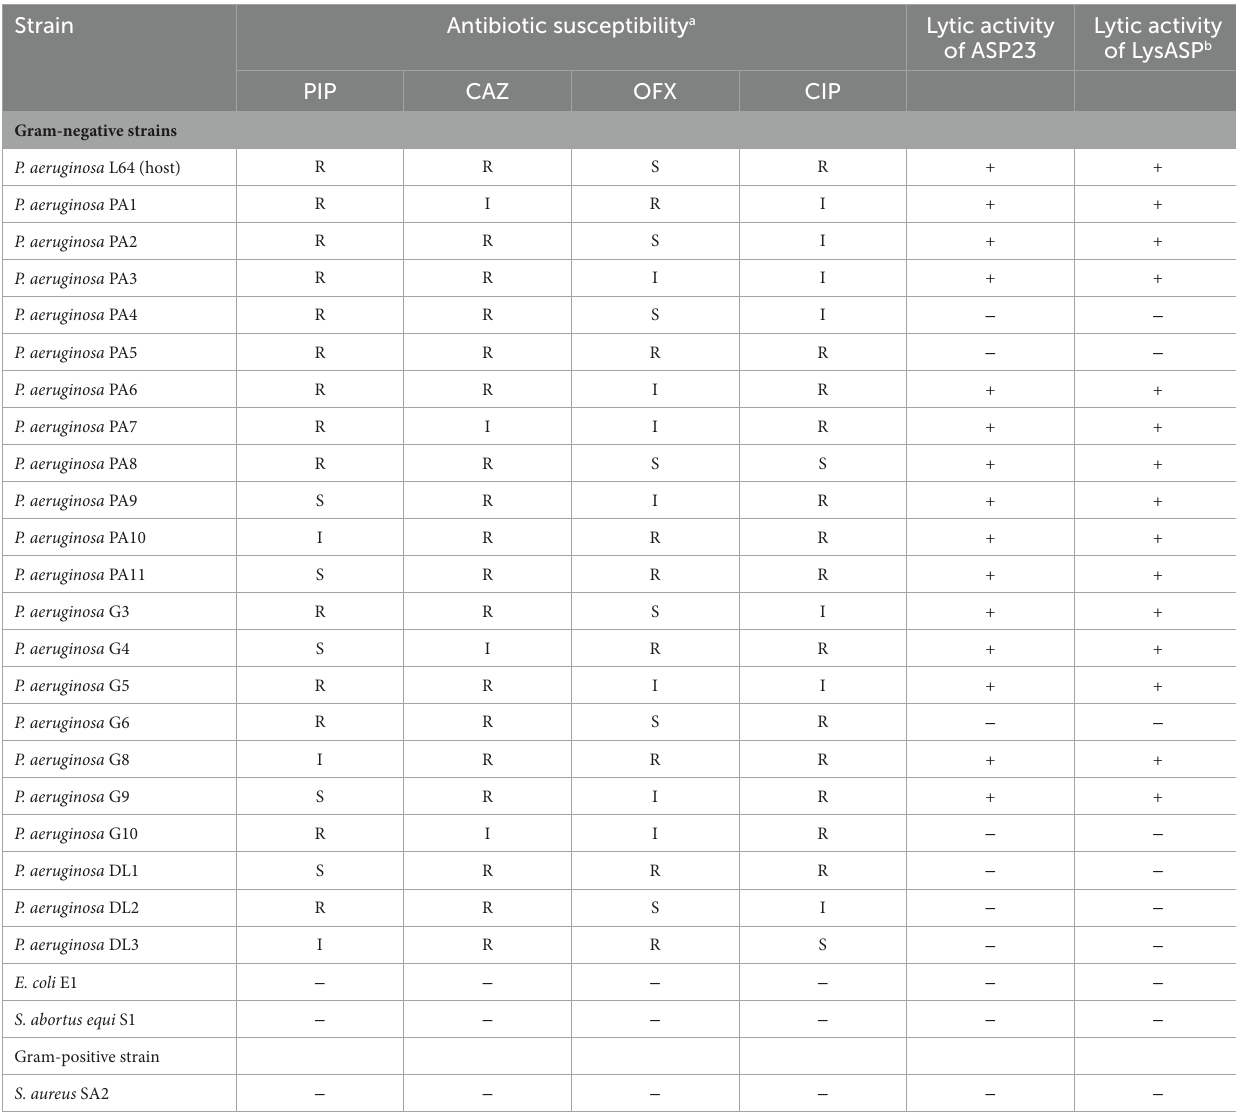
TABLE 2 Antibacterial activities of phage ASP23 and LysASP toward different species of bacteria.